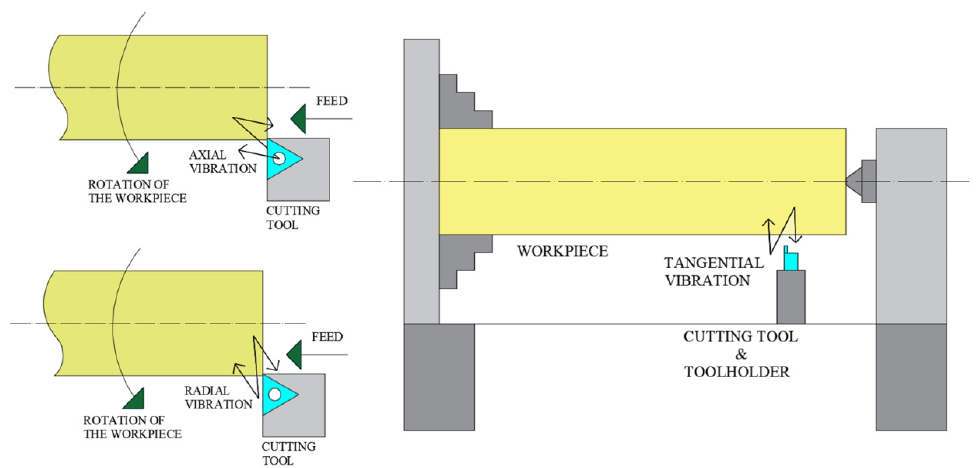
Figure 2. Vibration components occurring on the machine tool.